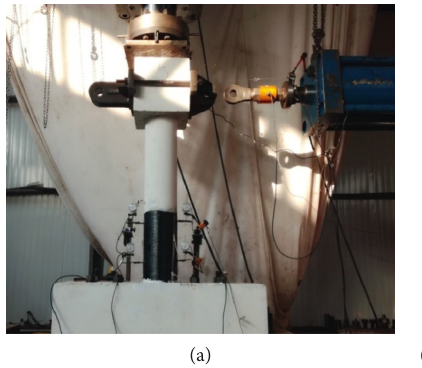
Figure 4: Loading system: (a) test devices; (b) actual lateral displacement